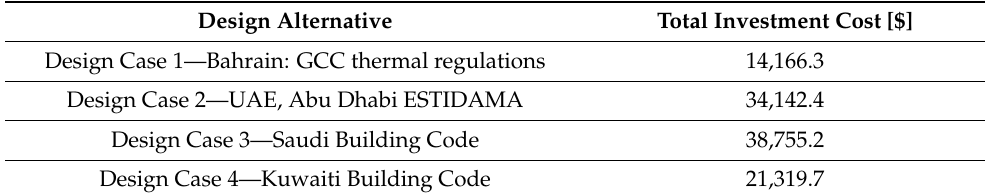
Table 4. Total capital cost of the design alternatives